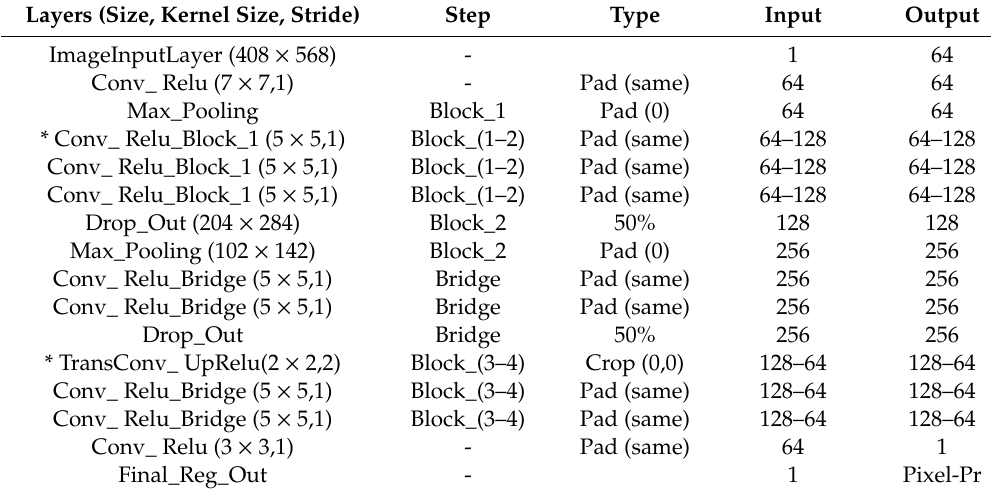
Figure 5. Diagram of the distortion correction network. Blue(Conv) represents the convolution layer, yellow(TransConv) represents the transposed convolution layer, and red and orange(Relu) represent the corresponding activation functions. Table 1. The detailed structure of the distortion correction network. Tag * means that the convolution information there was extracted, then directly superimposed with the information of the symmetric transposed convolution channel, and finally fused by convolution.